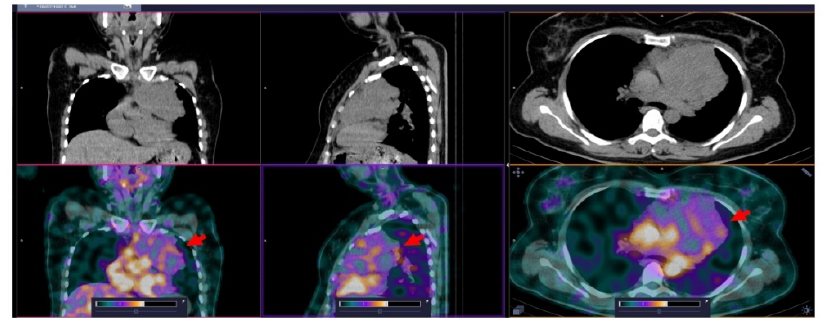
Figure 5. SPECT/CT images of patient 3 at 2 h after injection of [ 99m Tc]Tc-TG. Elevated [ 99m Tc]Tc-TG uptake in the mediastinal tumor (SUVmax = 1.3) is visualized (arrows). The upper setting of the scale window (60% of the maximum number) was adjusted to visualize the lesion.